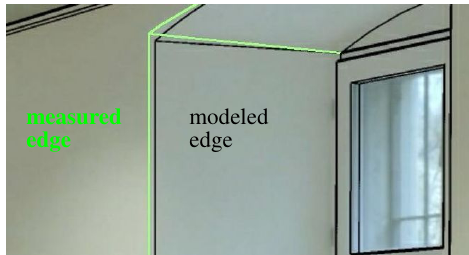
Figure 1. Image oriented in the BIM system showing both modeled BIM objects and those not included in the model.